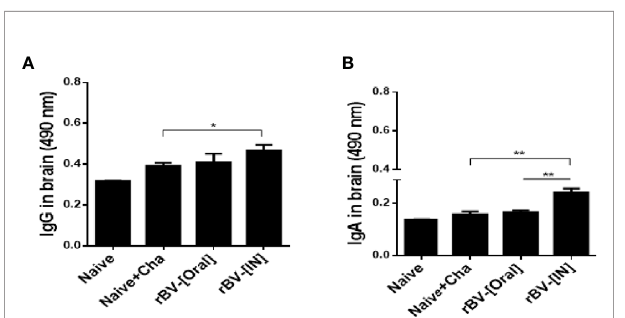
FIGURE 3 | IgG and IgA antibody responses in the brain after T. gondii ME49 infection. T. gondii -speci fi c IgG (A) and IgA (B) antibody responses were detected in immunized mice 16 days after challenge infection. Data are presented as mean ± SD and asterisks indicate statistical differences between groups (* P < 0.05, ** P < 0.01).